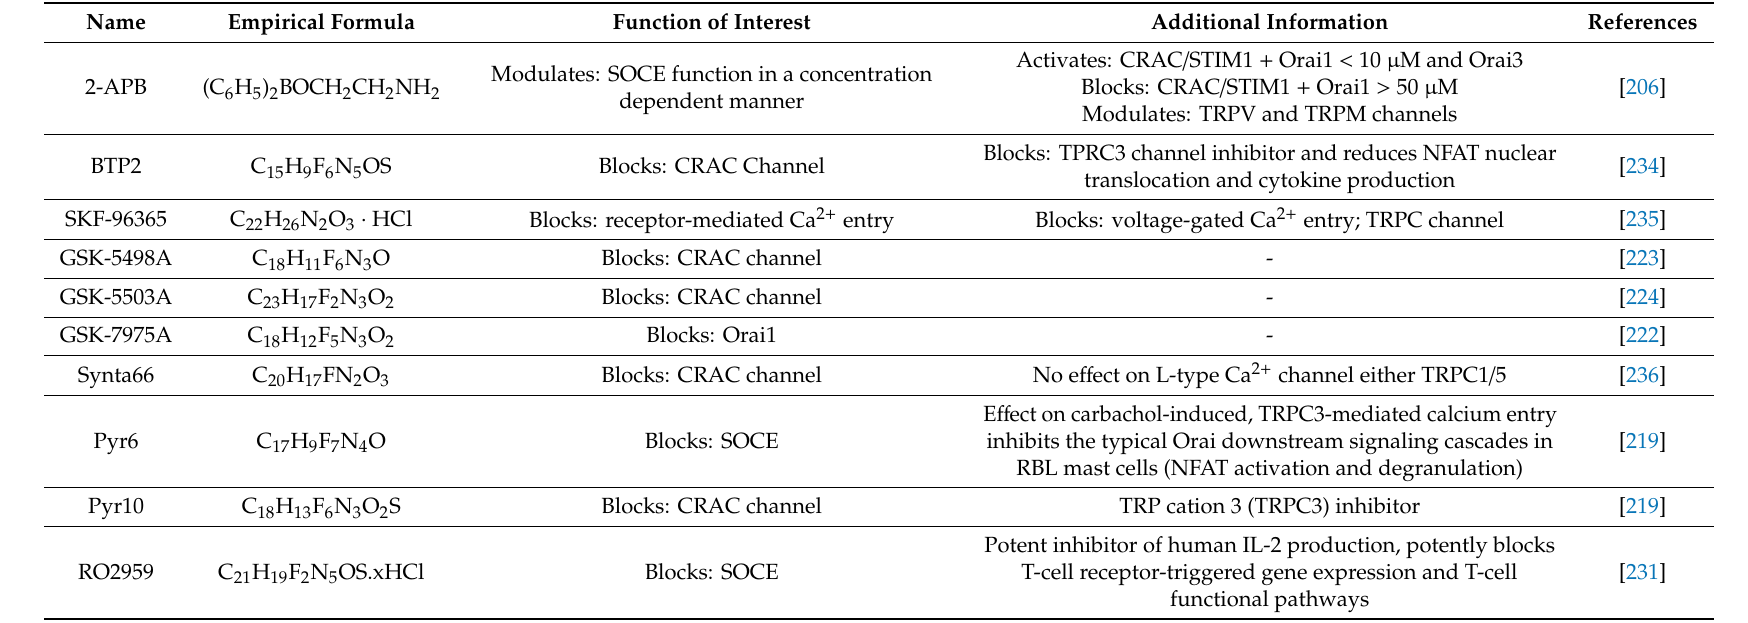
Table 1. CRAC channel modulators. This table summarizes the most common CRAC channel modulators together with their empirical formula, the function of interest and some additional